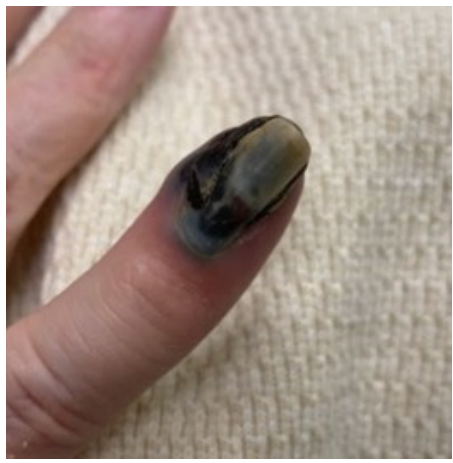
Figure 1. Presenting image of the acral metastasis, with a pathologic assessment consistent with a metastatic endometrial adenocarcinoma.